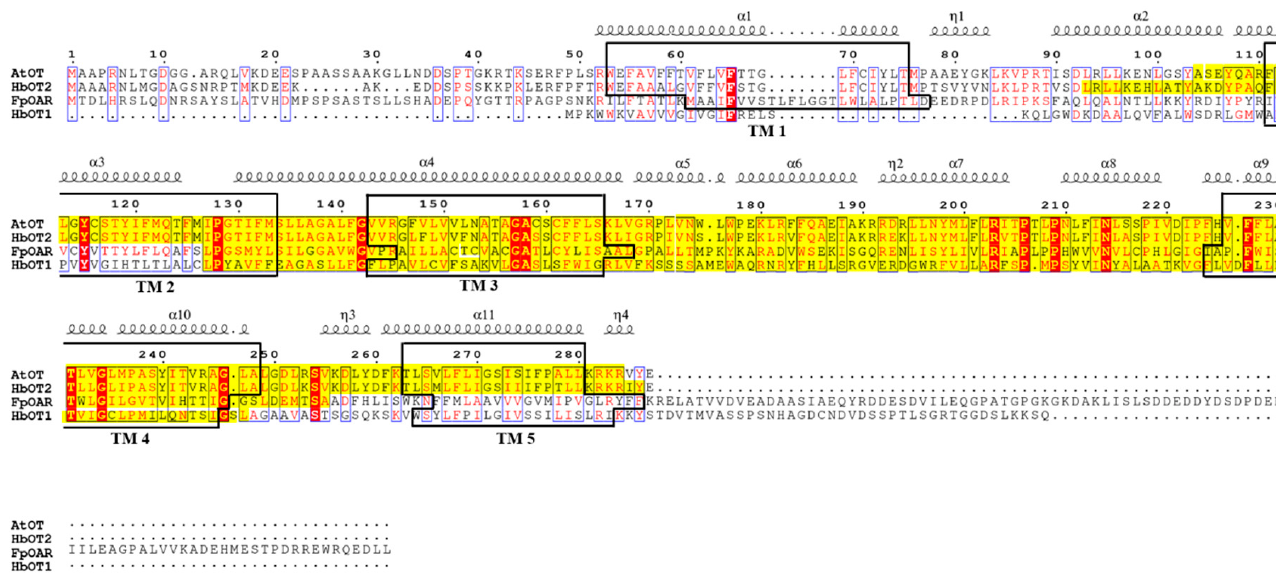
Figure 1. Multiple sequence alignment of FpOAR, HbOT1, HbOT2, and AtOT . Different secondary structures are labelled above a specific sequence, black boxes represent the transmembrane domains (TM1–TM5) of the protein, and the yellow highlighted fragment represents the SNARE-assoc con- served domain of the protein. Conserved and similar residues are identified by red shadows and blue boxes, respectively.